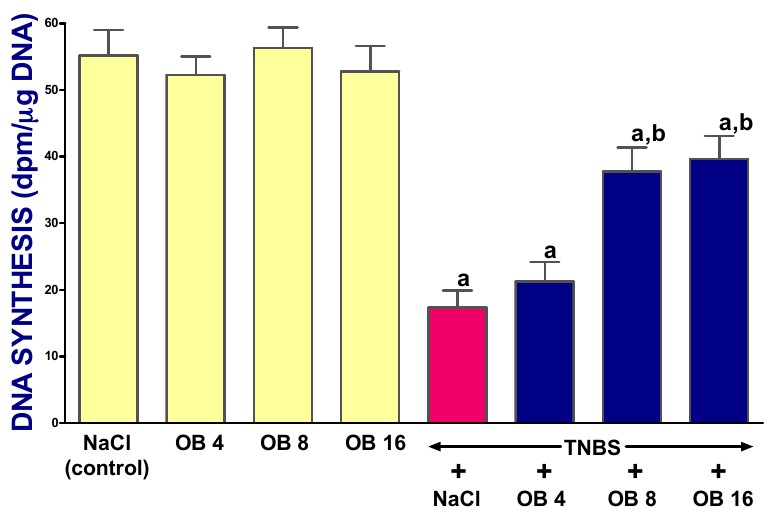
Figure 4. Effect of saline (NaCl) or obestatin given at doses of 4 nmol/kg (OB4), 8 nmol/kg (OB8), or 16 nmol/kg (OB16), and TNBS-induced colitis on mucosal DNA synthesis in the colon. Mean ± SEM. n = 10 in each group of animals. a p < 0.05 when compared with control; b p < 0.05 when compared with colitis + NaCl.